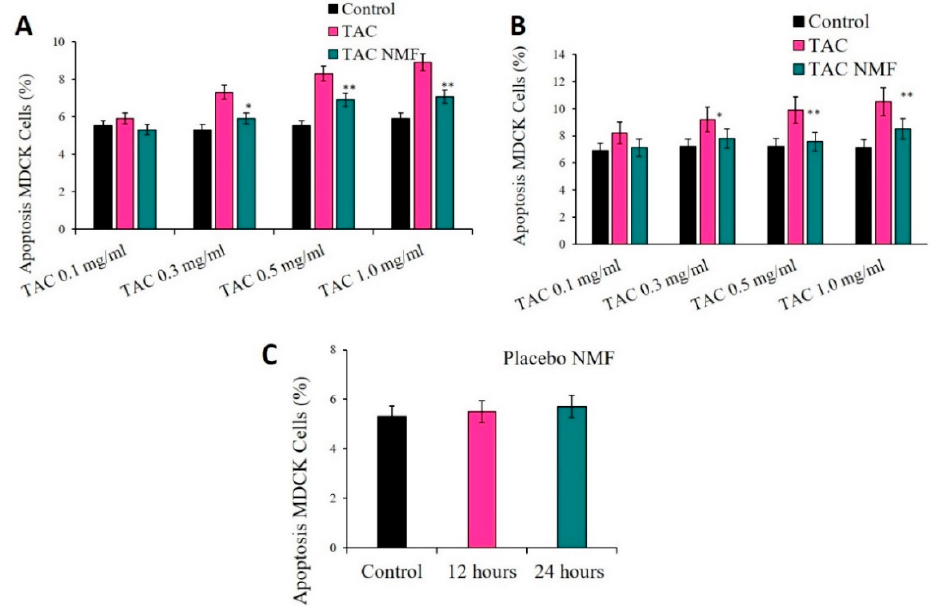
Figure 14. In-vitro biocompatibility study of TAC-NMF in MDCK kidney cells by determining by Annexin V / FITC and PI-Staining. MDCK cells were treated for 12 ( A ) and 24 ( B ) hours with TAC and TAC-NMF at concentrations of tacrolimus at 0.1, 0.3, 0.5 and 1.0 mg / mL. MDCK cells were also treated with placebo NMF ( C ) for 12 and 24 h and analyzed for apoptosis by Annexin V / FITC and PI-Staining. Results are expressed as mean of three independent experiments, n = 3 ± SD. (* p ≤ 0.05 as compared to TAC ** p ≤ 0.01 as compared to TAC) .